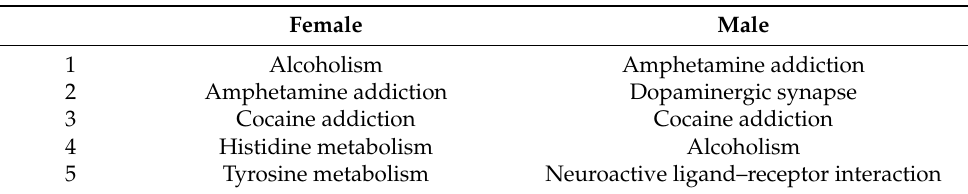
Table 2. Top 5 statistics of KEGG pathway enrichment for DEGs in the brains of 2.5 × FA female and male mice.